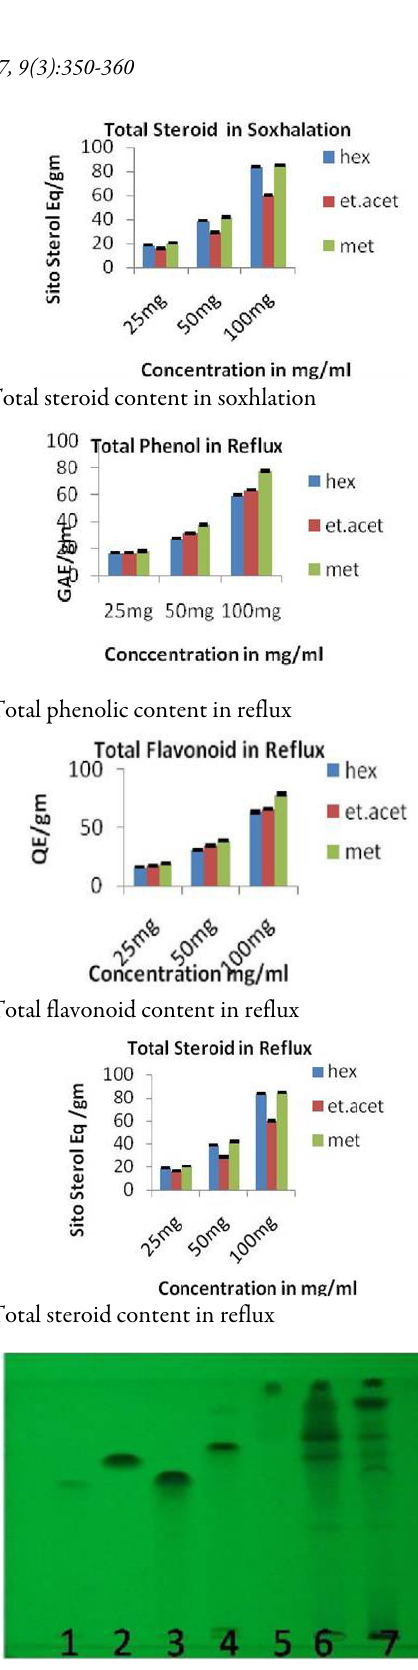
Fig. 10. HPTLC fingerprinting profile for various secondary